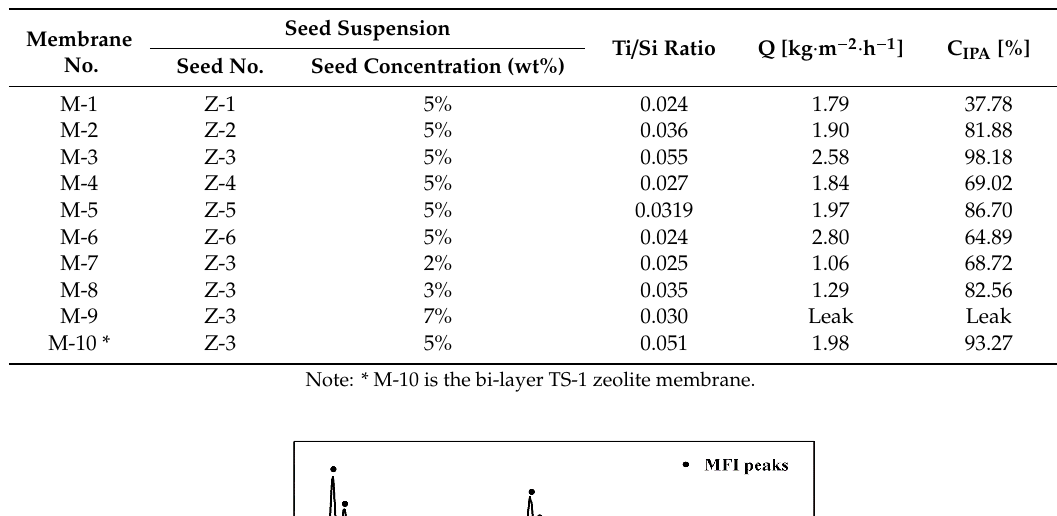
Table 2. Catalytic performance and Ti / Si ratio of the TS-1 zeolite membranes with di ff erent seeded crystals.